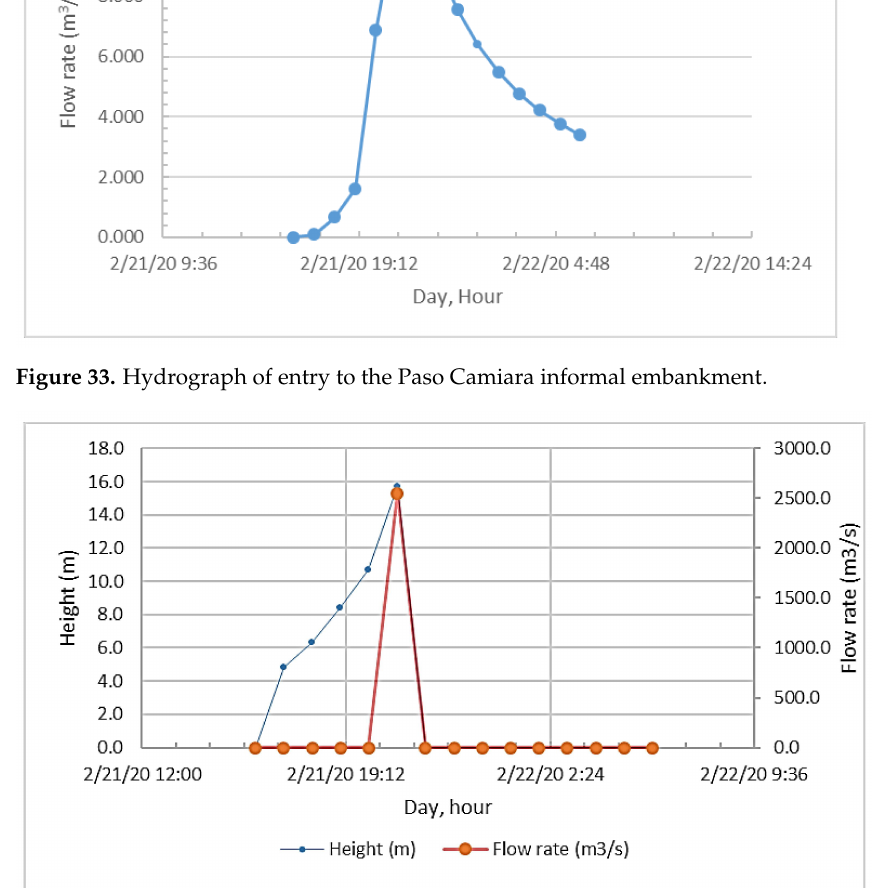
Figure 34. Hydrographs of water height in the dam and flow discharged due to the collapse of the Paso Camiara